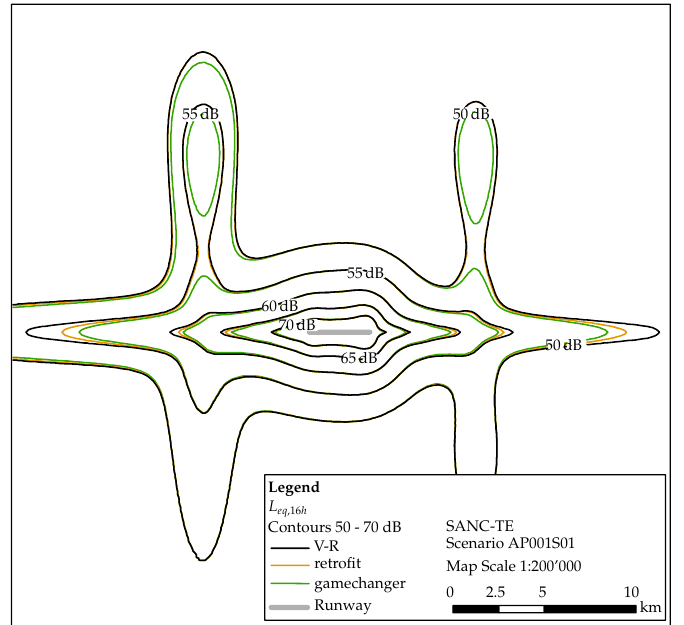
Figure 16. Influence of the three aircraft types V-R, “retrofit” and “gamechanger” on the total sound exposure level L eq ,16 h .